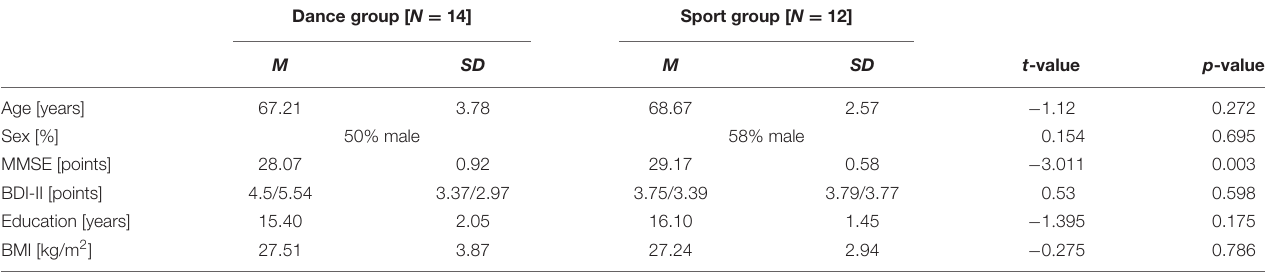
TABLE 1 | Demographic information at baseline of analyzed participants ( N =